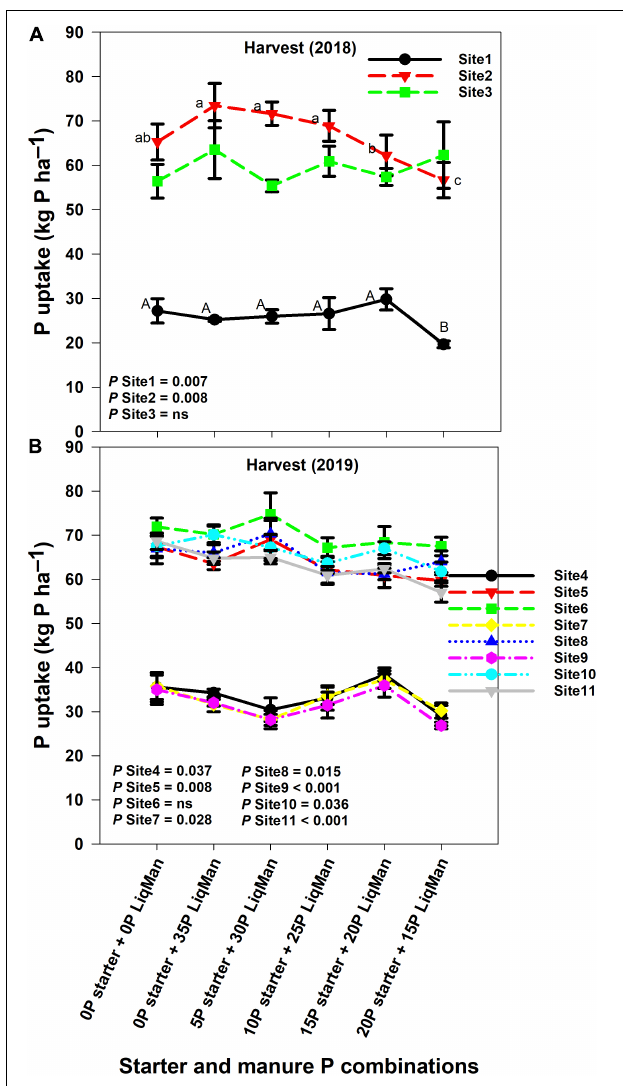
FIGURE 7 | Corn P uptake at harvest with application of starter P rates and dairy manure across 11 sites (2018 and 2019) in the Fraser Valley, BC. Dairy manure was applied at 6-leaf stage. Error bars represent standard deviations of the means.